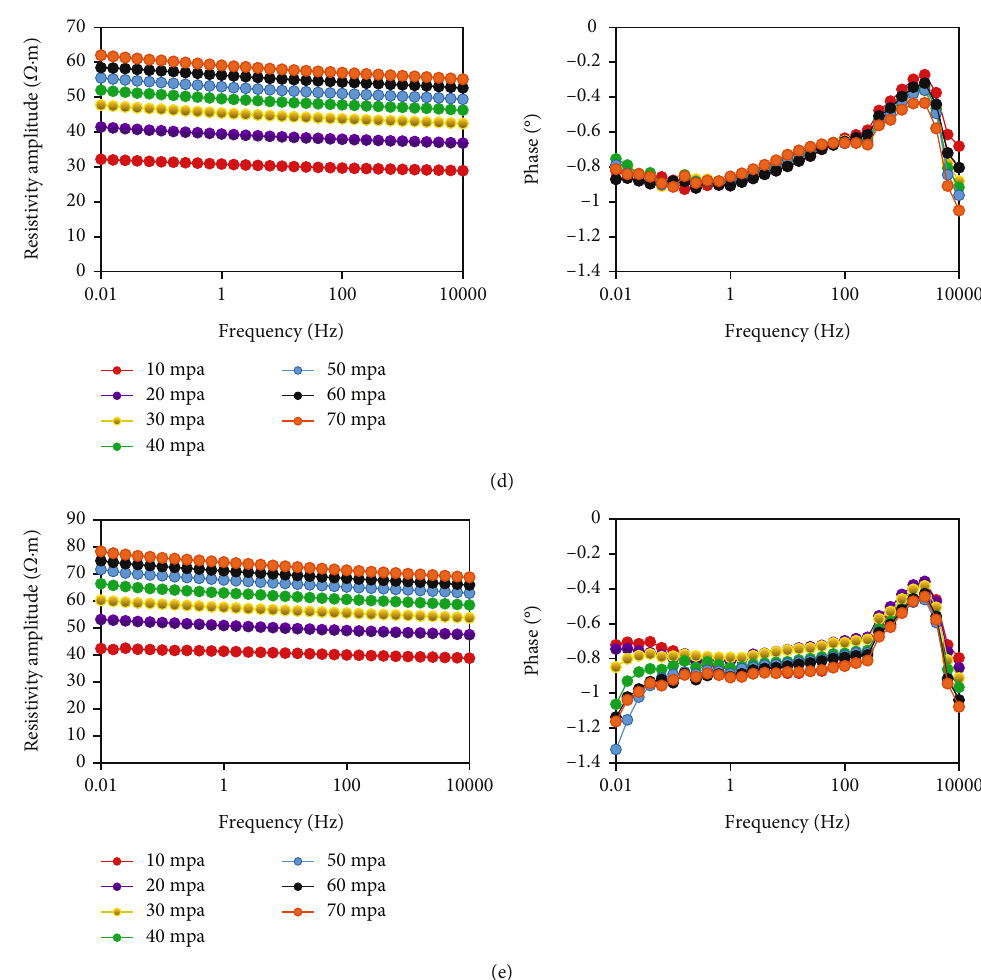
Figure 5: (a – e) The amplitude and phase curves of the complex resistivity of samples 1, 2, 3, 4, and 5 under variable pressures, respectively. The left column shows the complex resistivity amplitude curves, and the right column shows the complex resistivity phase